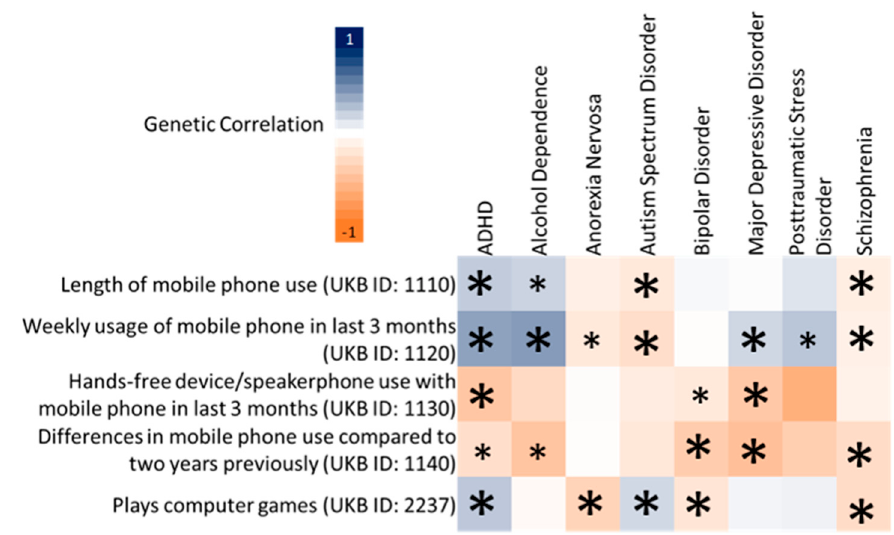
Figure 1. Linkage disequilibrium score regression genetic correlations for computerized device use and psychiatric disorder (attention deficit hyperactivity disorder (ADHD), alcohol dependence, autism spectrum disorder, bipolar disorder, anorexia nervosa, major depressive disorder, post-traumatic stress disorder, and schizophrenia) pairs. Large asterisks indicate genetic correlations surviving multiple testing correction ( p = 1.25 × 10 − 3 ), while small asterisks indicate nominally significant genetic correlations. Genetic correlations significant after Bonferroni correction are provided in Table S1.